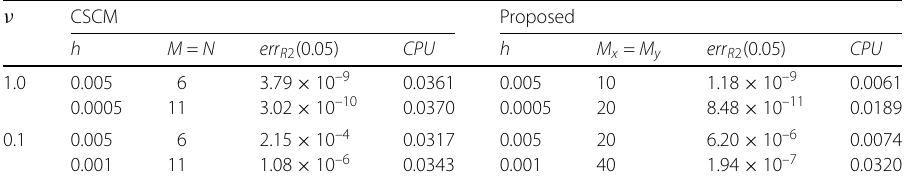
Table 3 Comparison of numerical errors obtained from the proposed method and the CSCM for Example 2 ν CSCM